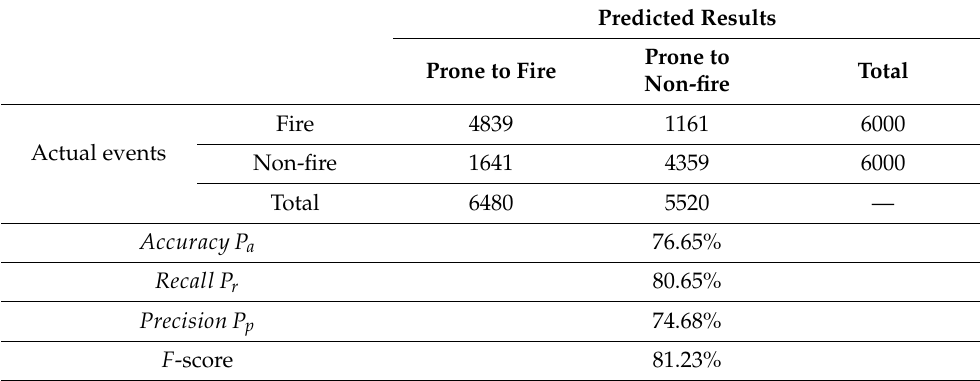
Table 6. Results of confusion matrix when 8 wildfire-related factors are used